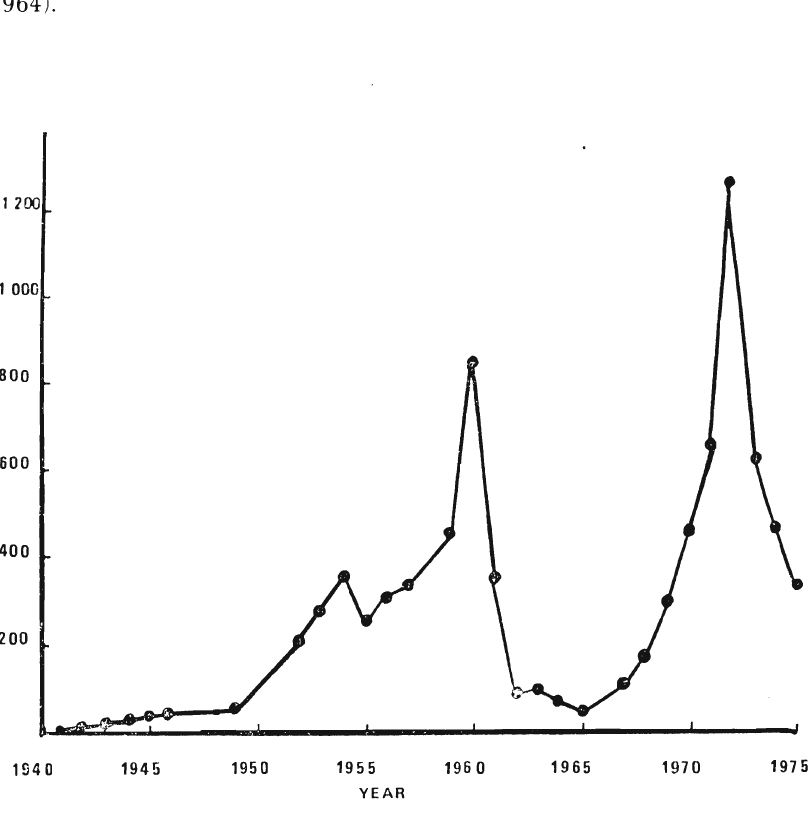
Fig. 1. Populatioll histOl), of springbok Antidorcas marsupiaLis in the Mountain Zebra National Park,